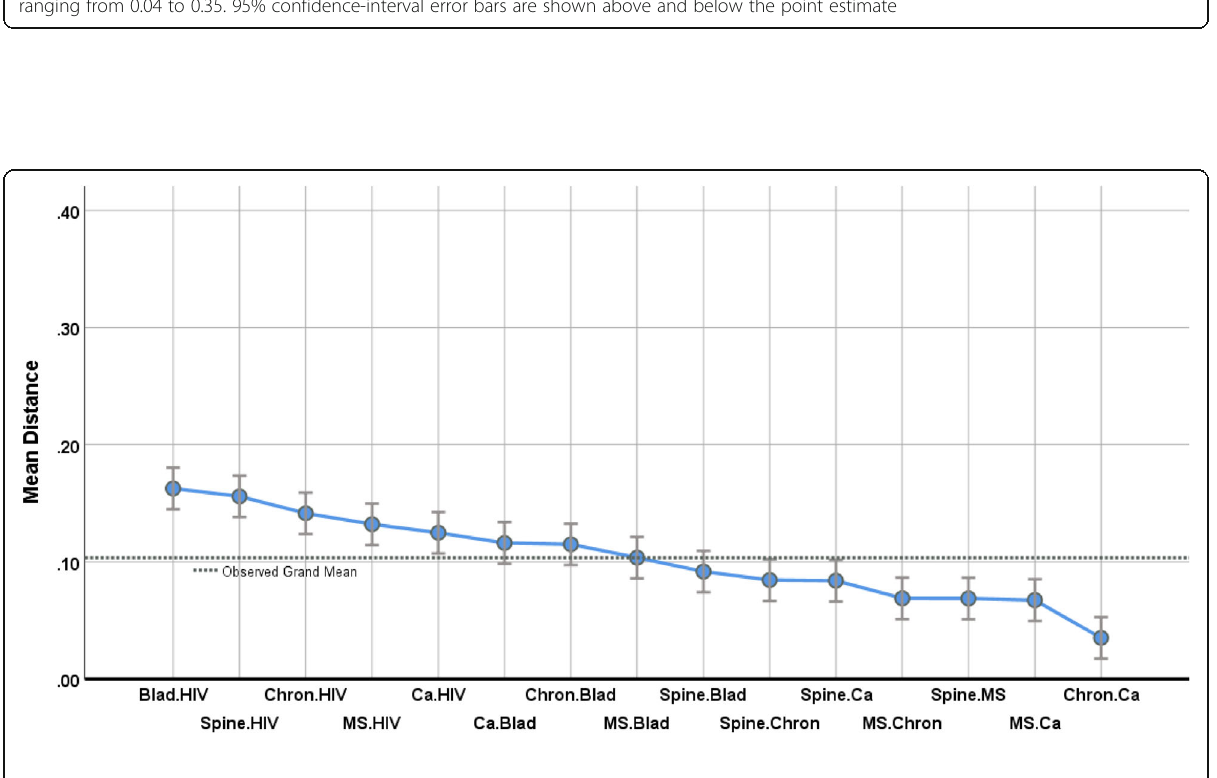
Fig. 2 Sampling of Experience: Z-to-r Distance between patient-group pairs for item-to-item correlations. This graph displays results from the second ANOVA. Each of 15 patient-group pairings is characterized on the Y-axis by the mean distance among 91 pairs of item-to-item correlations. Patient- group pairings showing similar item-to-item correlations (low mean distances) appear at right. Mean distances are narrowly dispersed, ranging from 0.04 to 0.16. 95% confidence-interval error bars are shown above and below the point